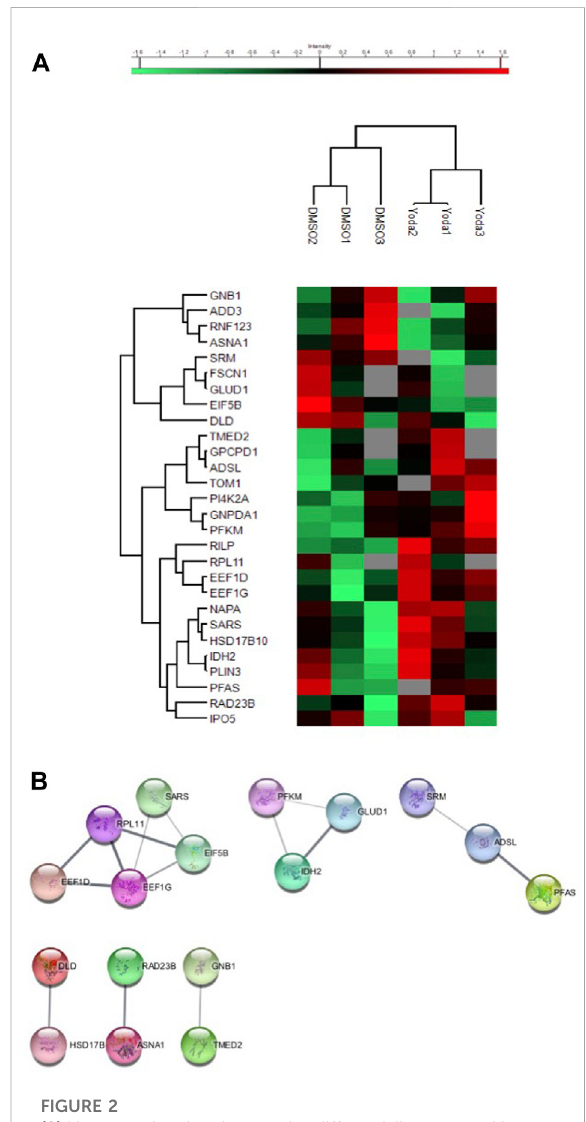
FIGURE 2 (A) Heatmap showing the proteins differentially expressed in CD34 + -derived reticulocytes after DMSO or Yoda1 exposure. (B) Analysis working string after Markov Clustering obtained from CD34 + -derived reticulocytes exposed to DMSO or YODA1, showing one main knot containing protein involved in protein